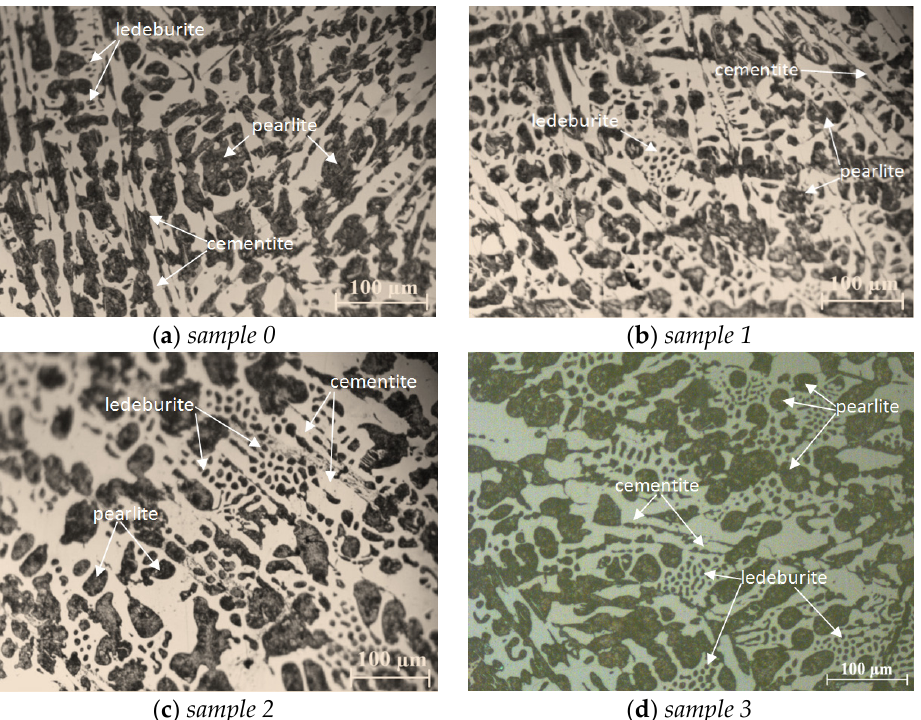
Figure 3. Microstructure photos of low-chromium cast iron (1% Cr) samples